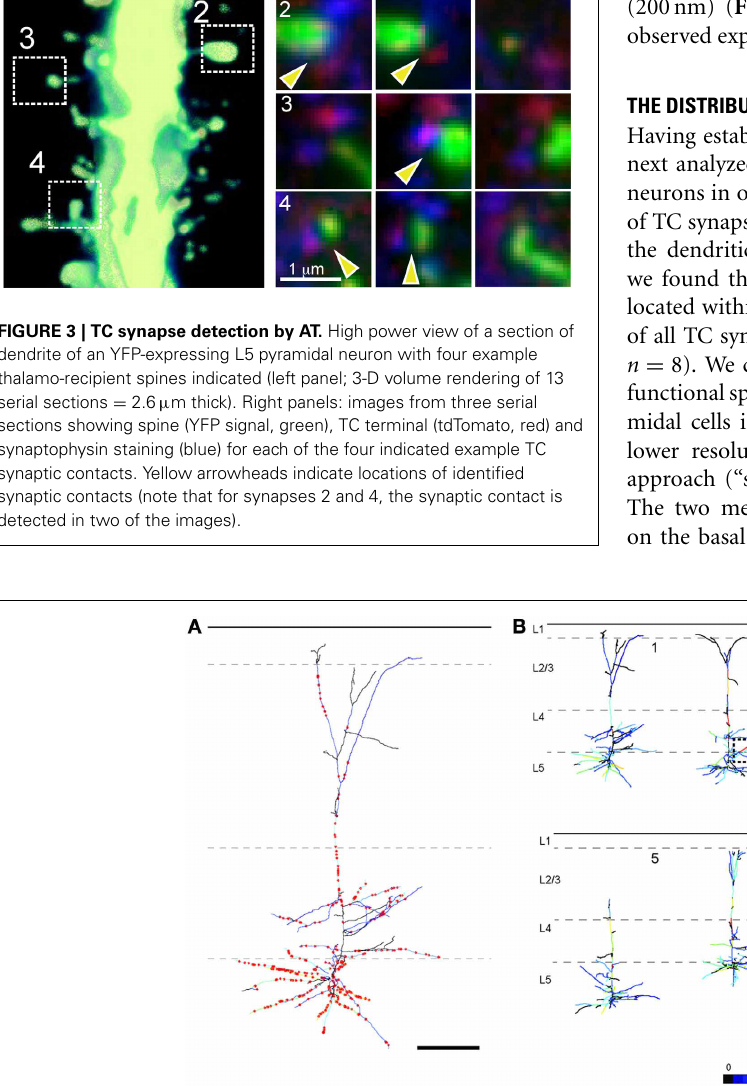
Frontiers in Neural